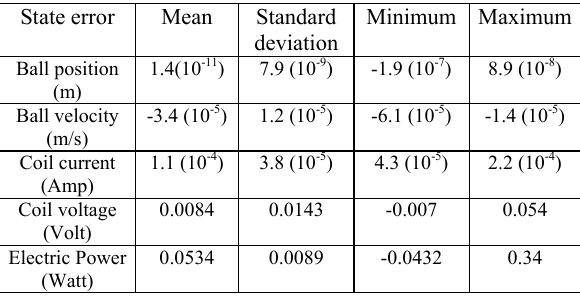
Table 2 Statistics for steady-state